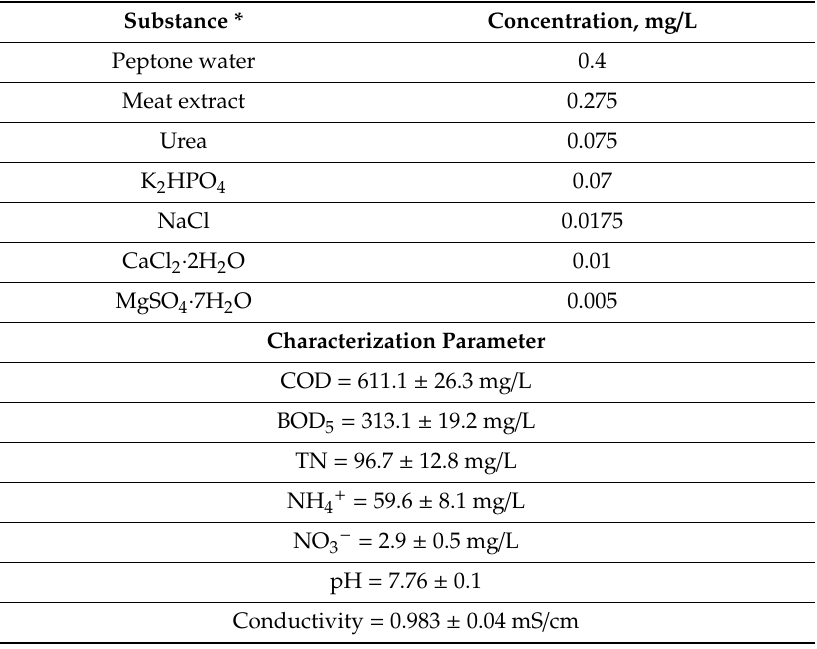
Table 1. Composition and physico-chemical characterization of synthetic municipal wastewater. BOD, biochemical oxygen demand; COD, chemical oxygen demand; TN, total nitrogen.